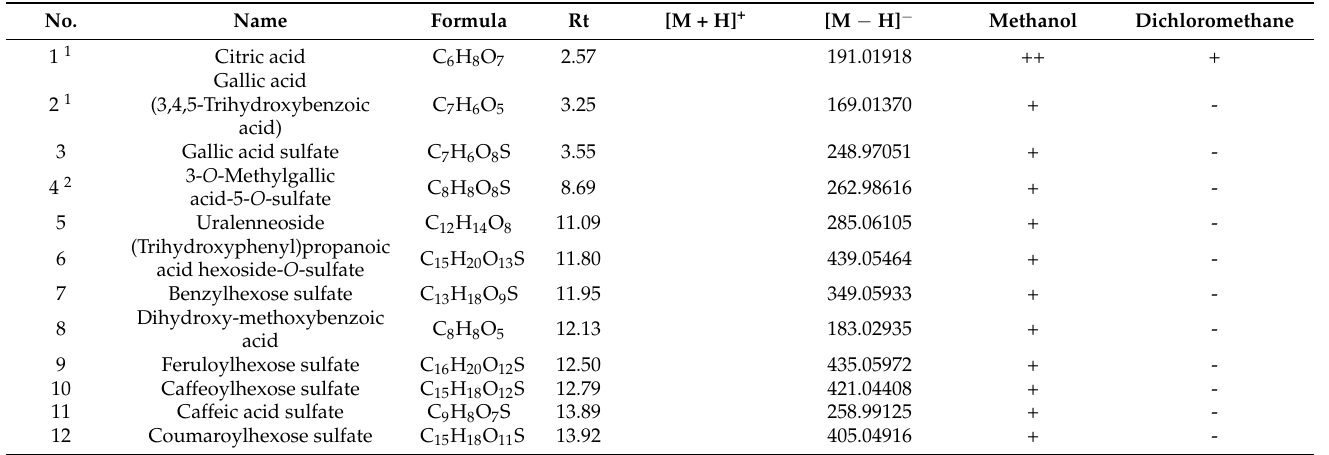
Table 1. HPLC-ESI-MS/MS tentative identification of the metabolites present in the methanol and dichloromethane extracts of the aerial parts of sea heath ( F. laevis